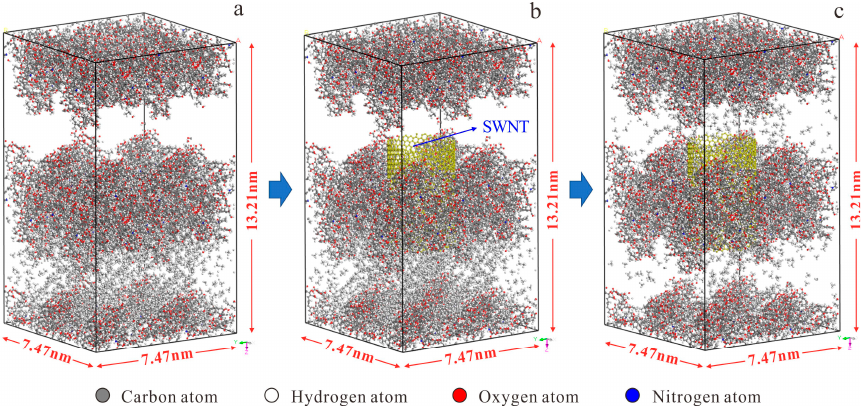
Figure 7. ( a ) Methane diffusion process at different temperatures, pressures and pore sizes in the molecular structure model of FK–3 coal. Molecular structural model; ( b ) snapshot of methane before diffusion in the molecular structural model; ( c ) and snapshot of methane after diffusion through a single-walled carbon nanotube (SWNT) in the molecular structure model.